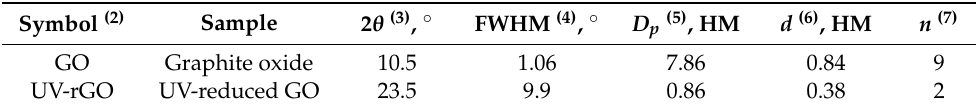
Figure 2. XRD patterns for graphite oxide GO (1), UV-rGO (2) and HOPG (3). Table 2. Calculation of CSR sizes according to X-ray diffraction analysis data for GO and UV-rGO using the Scherrer method (1)